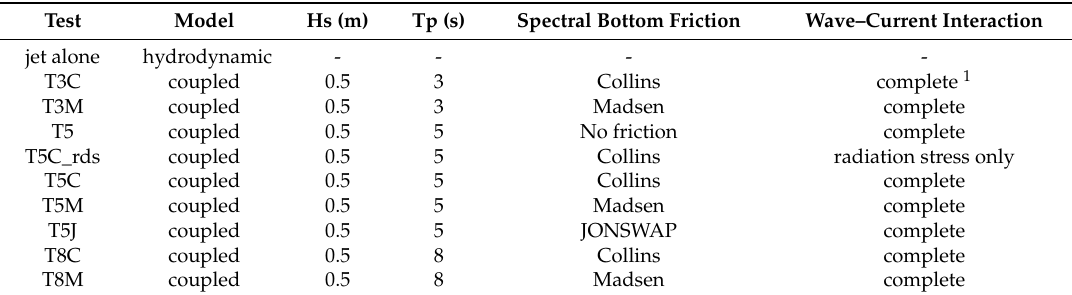
Table 1. List of the simulations